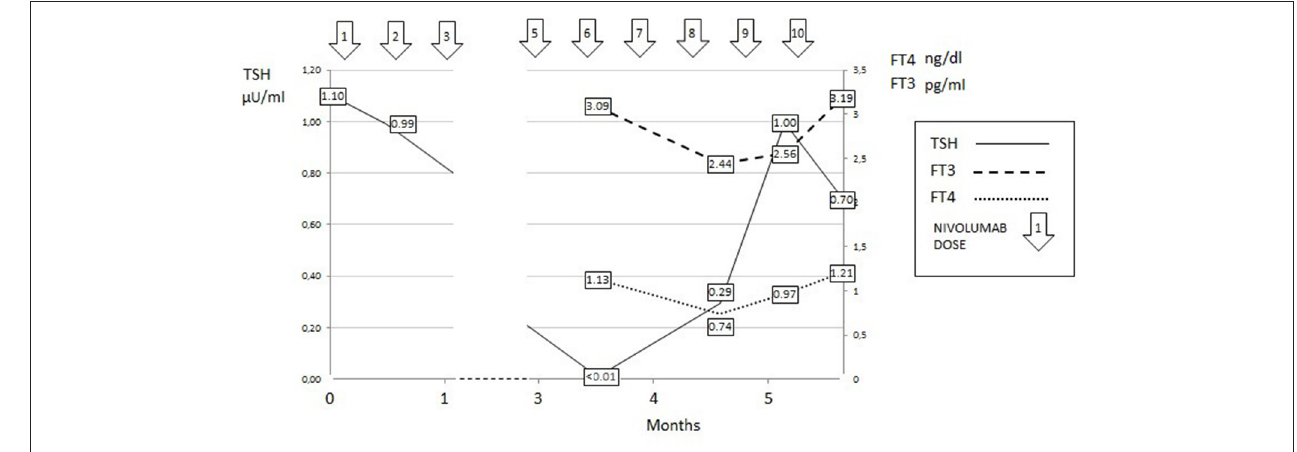
FIGURE 1 | Thyroid hormone profile of Case 1.